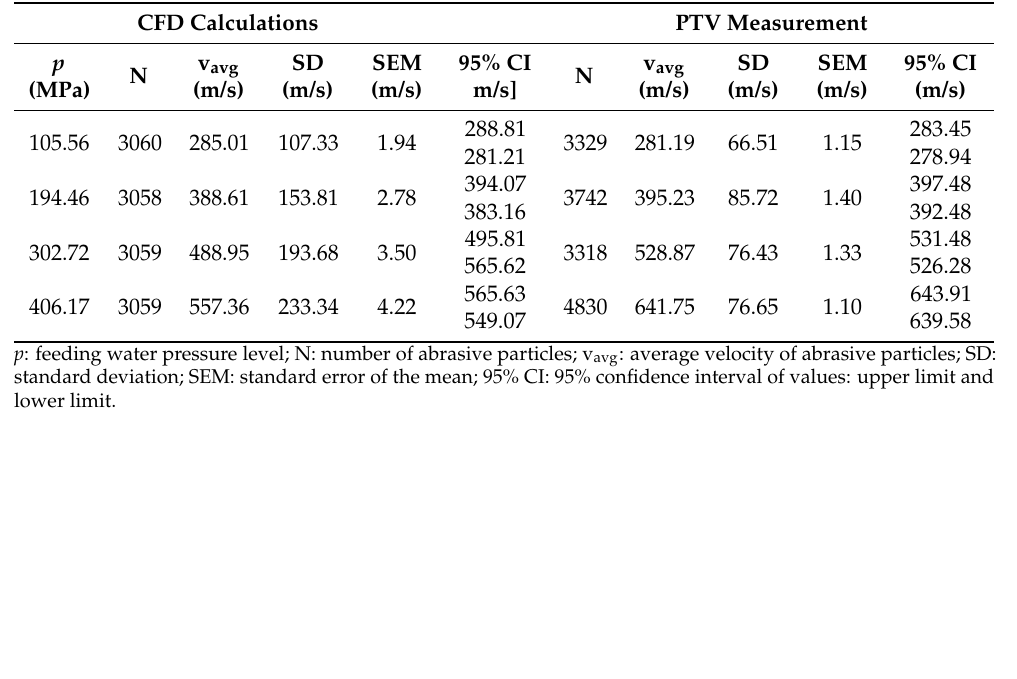
Table 3. Comparison of the average values of abrasive particle velocities from CFD calculations and PTV measurement for an abrasive mass flow rate of 200